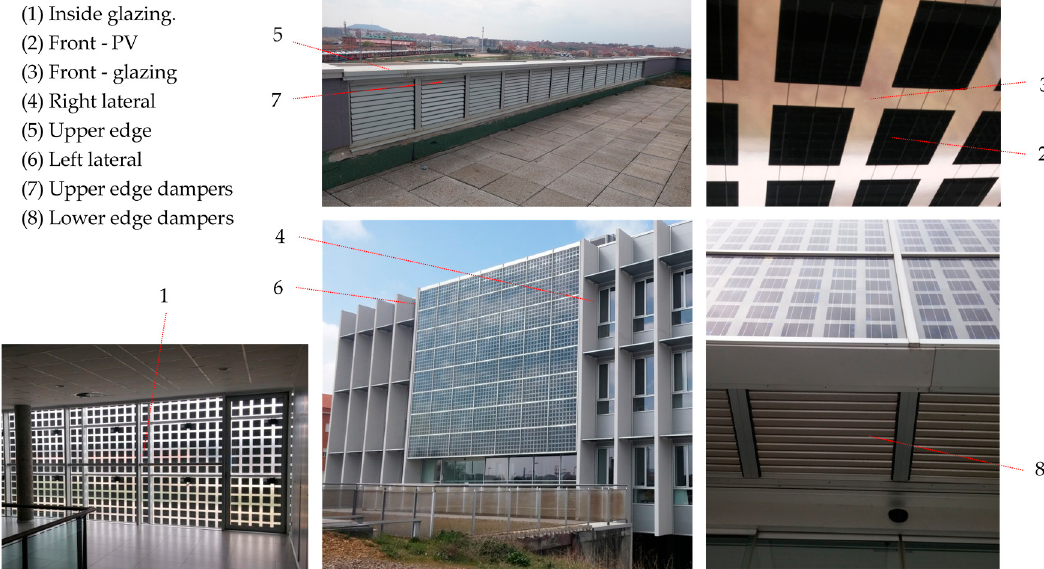
Figure 1. Different views of the ventilated façade with photovoltaics (PV) modules and zones studied in the model.